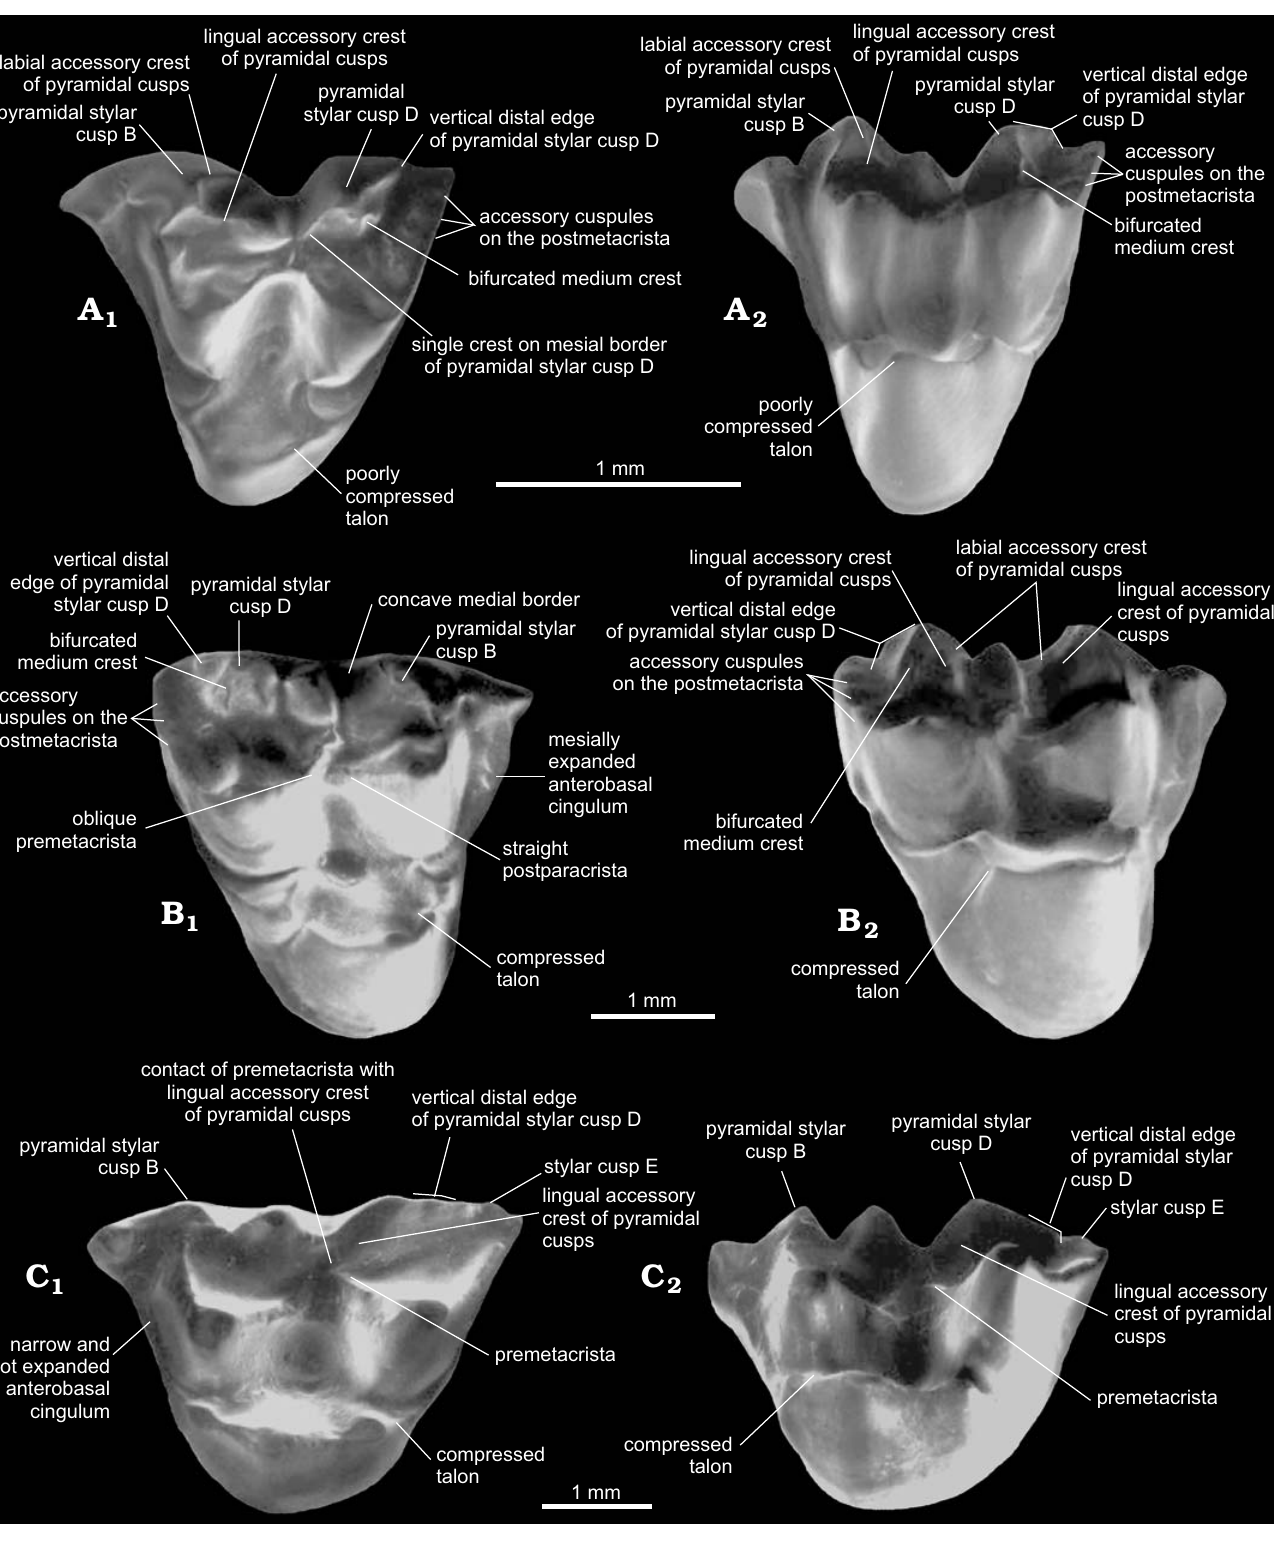
Fig. 3. Dental characters in selected species of Alphadontia. A . Nortedel phys minimus Case, Goin, and Woodburne, 2005 (UW 27031) from V-65127, Bug Creek Anthills, Hell Creek Formation, late Maastrichtian (Lancian NALMA), Montana, USA; LM1 in occlusal (A 1 ) and lingual (A 2 ) views. B . Hatcheritherium alpha Clemens, 1966 (YPM 14912) from Quarry 9, Lance Creek, Lance Formation, late Maastrichtian (Lancian NALMA), Wyoming, USA; RM1 in occlusal (B 1 ) and lingual (B 2 ) views. C . Ectocentrocristus foxi Rigby and Wolberg, 1987 (AMNH 77372) from the upper part of Judith River Formation, late Campanian (Judithian NALMA), Montana, USA; LM3 in occlusal (C 1 ) and lingual (C 2 ) views. Adapted from Case et al. (2005: figs. 4, 5,